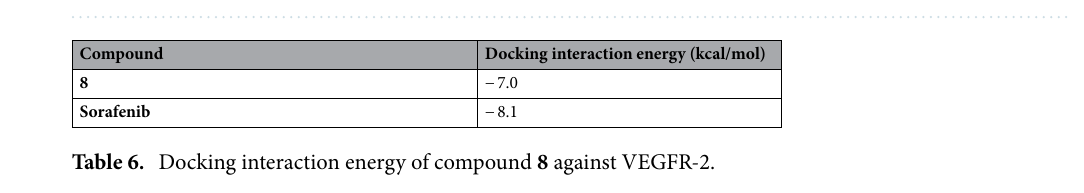
Figure 7. 2D binding mode and residues involved in the recognition of compound 8 , alpelisib and LY294002 against PI3Kα.